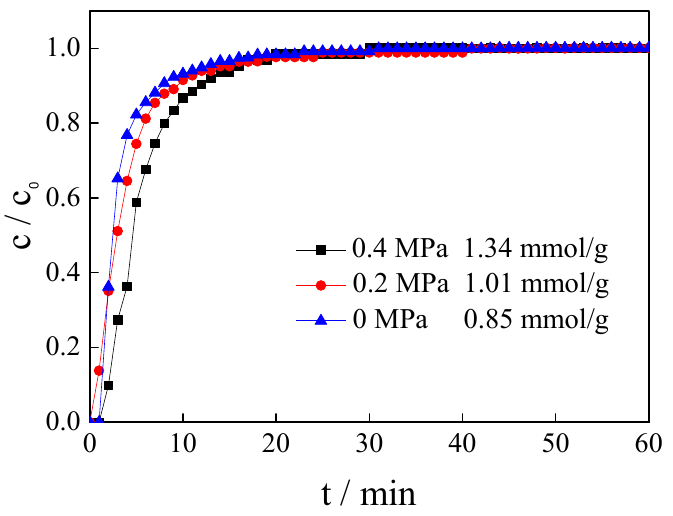
Figure 8. Adsorption curves and CO 2 capacity of magnesite modified by [APMIM]Br under different pressures (3 g, 10% loading amount, 50 ◦ C and 150 mL/min).